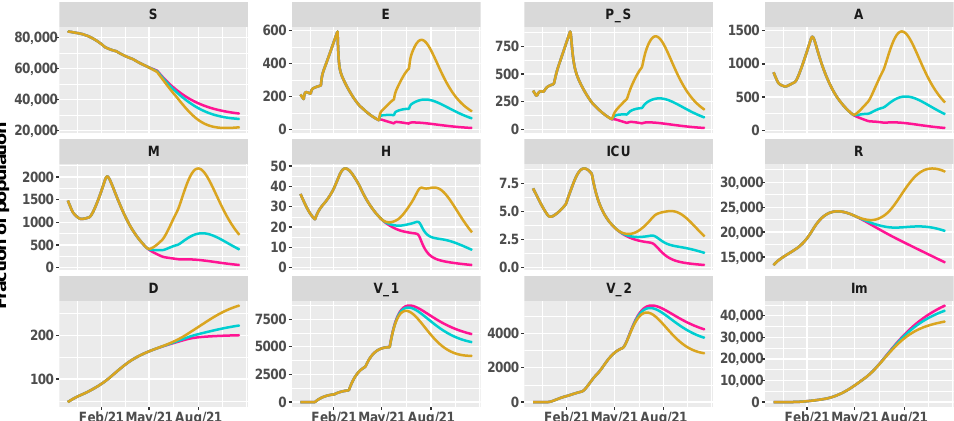
Figure 5. Projections of the epidemic evolution with a vaccination schedule of 8000 first doses of vaccines per day in Umbria (slow vaccination). Each line corresponds to a different reopening strategy, i.e., different values of transmission rate parameters b e and b 0 (yellow for high values, blue for medium values, and pink for low values).